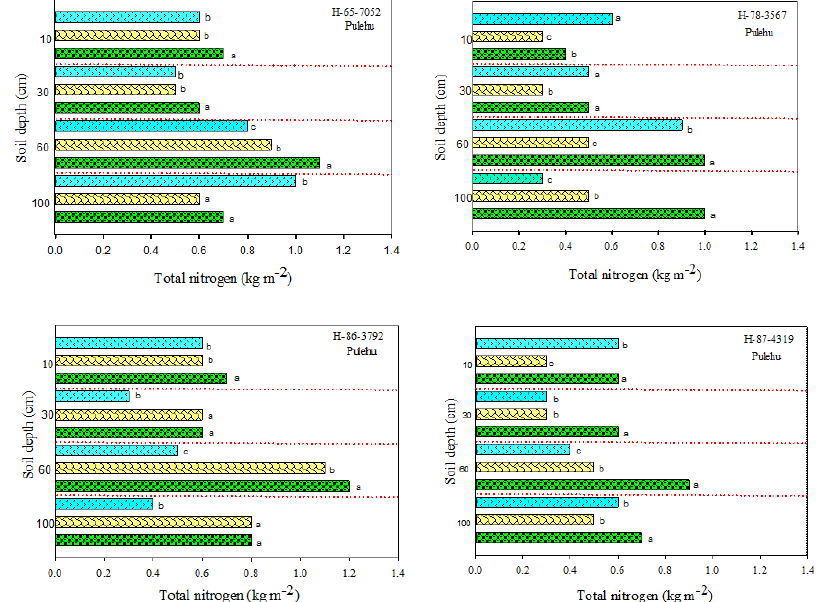
Figure 5. Total Nitrogen in Pulehu soils. Color represents sugarcane growing stages ( i.e. , blue-tillering, yellow-grand growth, green-maturity) when the soil samples were collected. Means followed by the same letter or no letters for the bars in each soil depth are not significantly different Tukey’s test at Pr < 0.05.